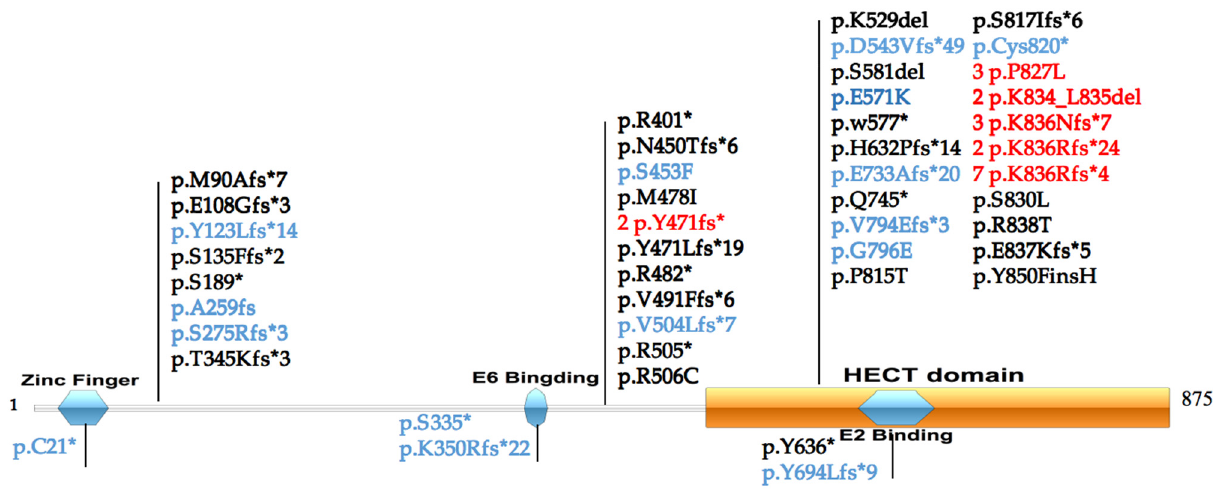
Figure 1. Variants in UBE3A protein relative to functional domains (NM_130838). Functional domains of UBE3A collected from the Conserved Domain Database (CDD) included Zinc finger (21–60), E6 Binding (378–396), HECT domain (518–875) and E2 Binding (635–694). The variants identified in this study are highlighted in blue. The recurrence variants are highlighted in red. * Stop codons